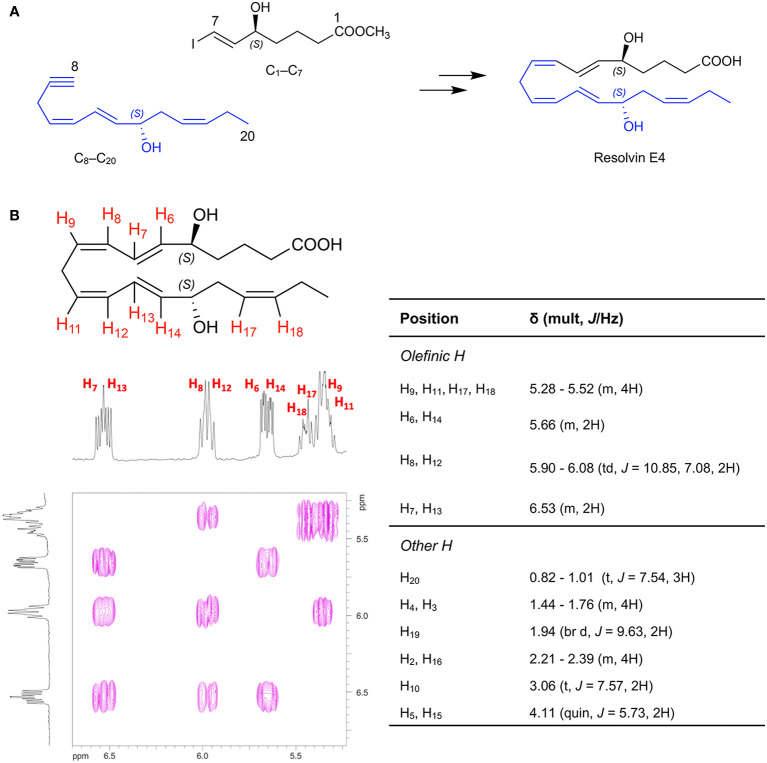
Retrosynthetic strategy for total organic synthesis and spectroscopic properties of Resolvin E4. The synthesis of RvE4 was accomplished by total organic synthesis from stereochemically pure starting building blocks and was characterized using NMR spectroscopy. (A) Synthetic precursors were prepared from enantiomerically pure commercially available starting materials and assembled using carbon-carbon bond coupling reactions between precursors C1–C7 (black), and C8–C20 (blue) to ensure absolute regio- and stereochemical control. (B) Double-bond geometry was assigned using two-dimensional 1H-1H NMR using a JNM ECZ-400S NMR spectrometer with a 400MHz magnet at 20.7°C on a JEOL ROYALPROBETM and referenced to the methanol-d4 (CD3OD) internal standard. The purple plot depicts positive contours of cross-peaks along the diagonal axis allowing for the full and detailed proton assignment. The enlarged region highlights the Z/E olefinic protons H6-H9, H11-H14, and H17-H18. This, in addition to the full 1H-NMR spectrum of chemical shifts and coupling constants, confirmed the structure of Resolvin E4.